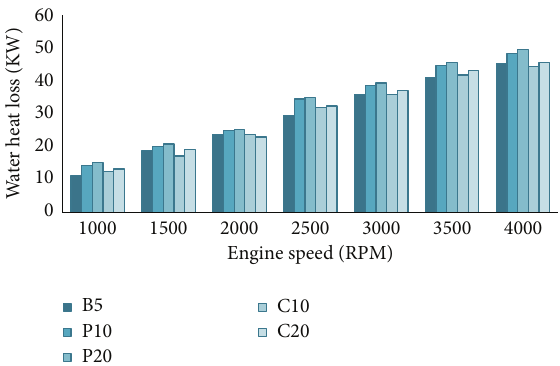
Figure 10: Water heat loss ( 𝑄 𝑤 ) variation at 100% load.